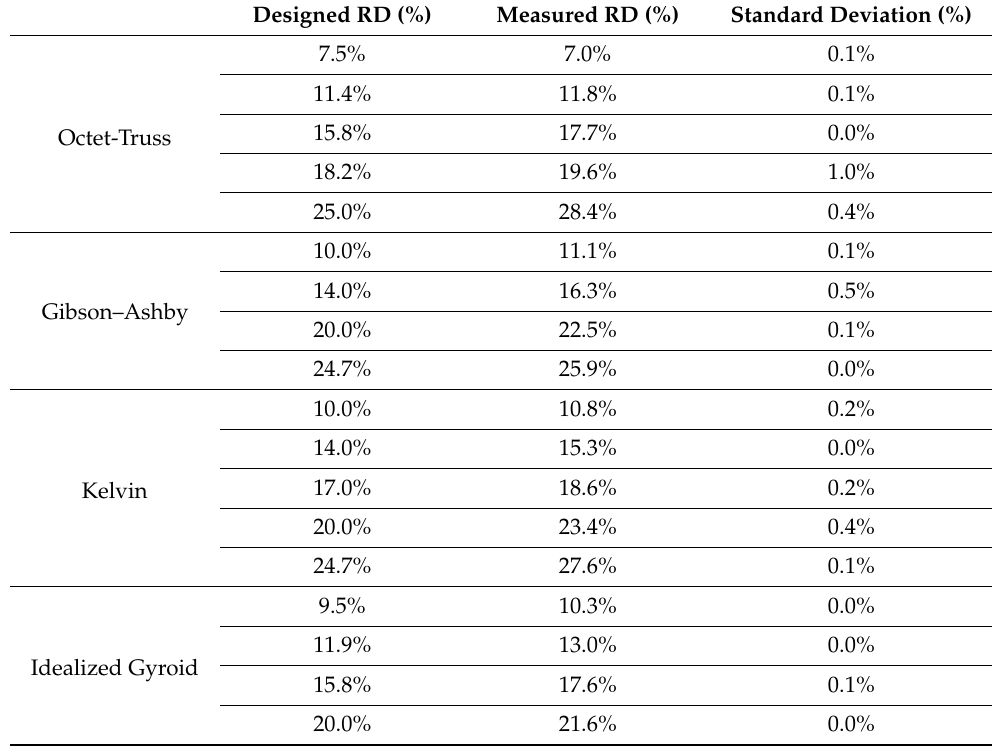
Table 3. Designed versus measured RD for the strut-based lattices.